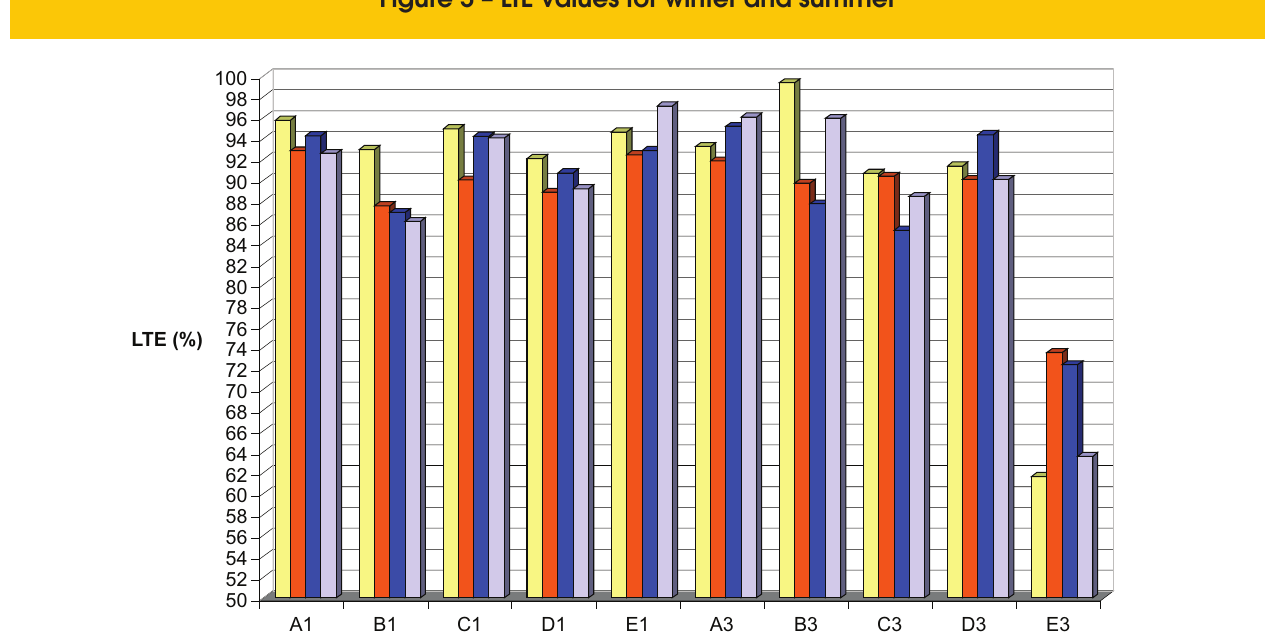
Figure 5 – LTE values for winter and